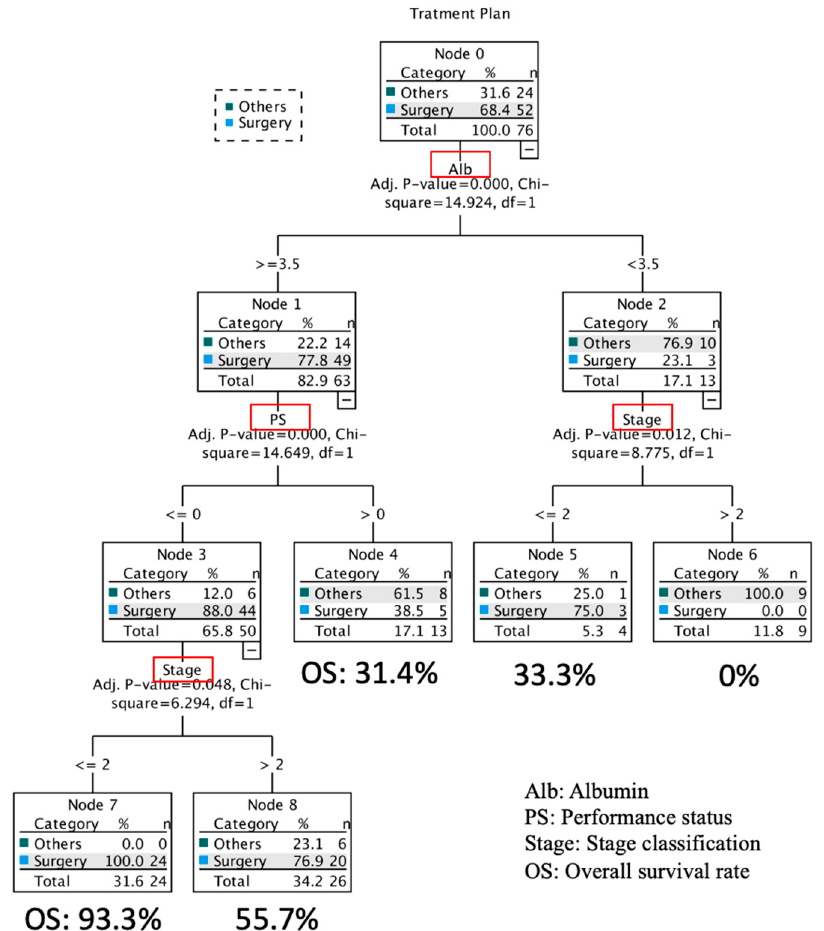
Figure 3. Decision tree analysis of treatment strategies. The items in red box were the three indepen-